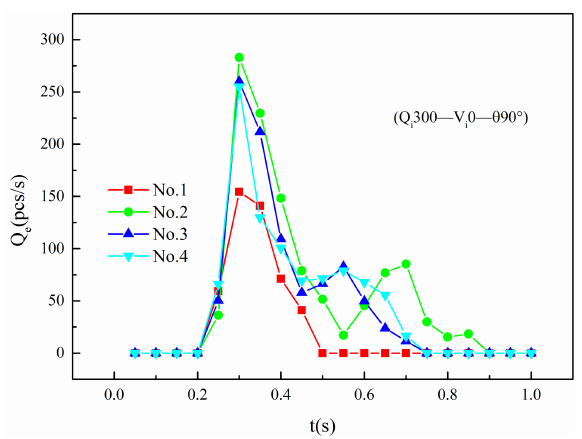
Figure 8. The change of Q e in different time with different initial ball position.